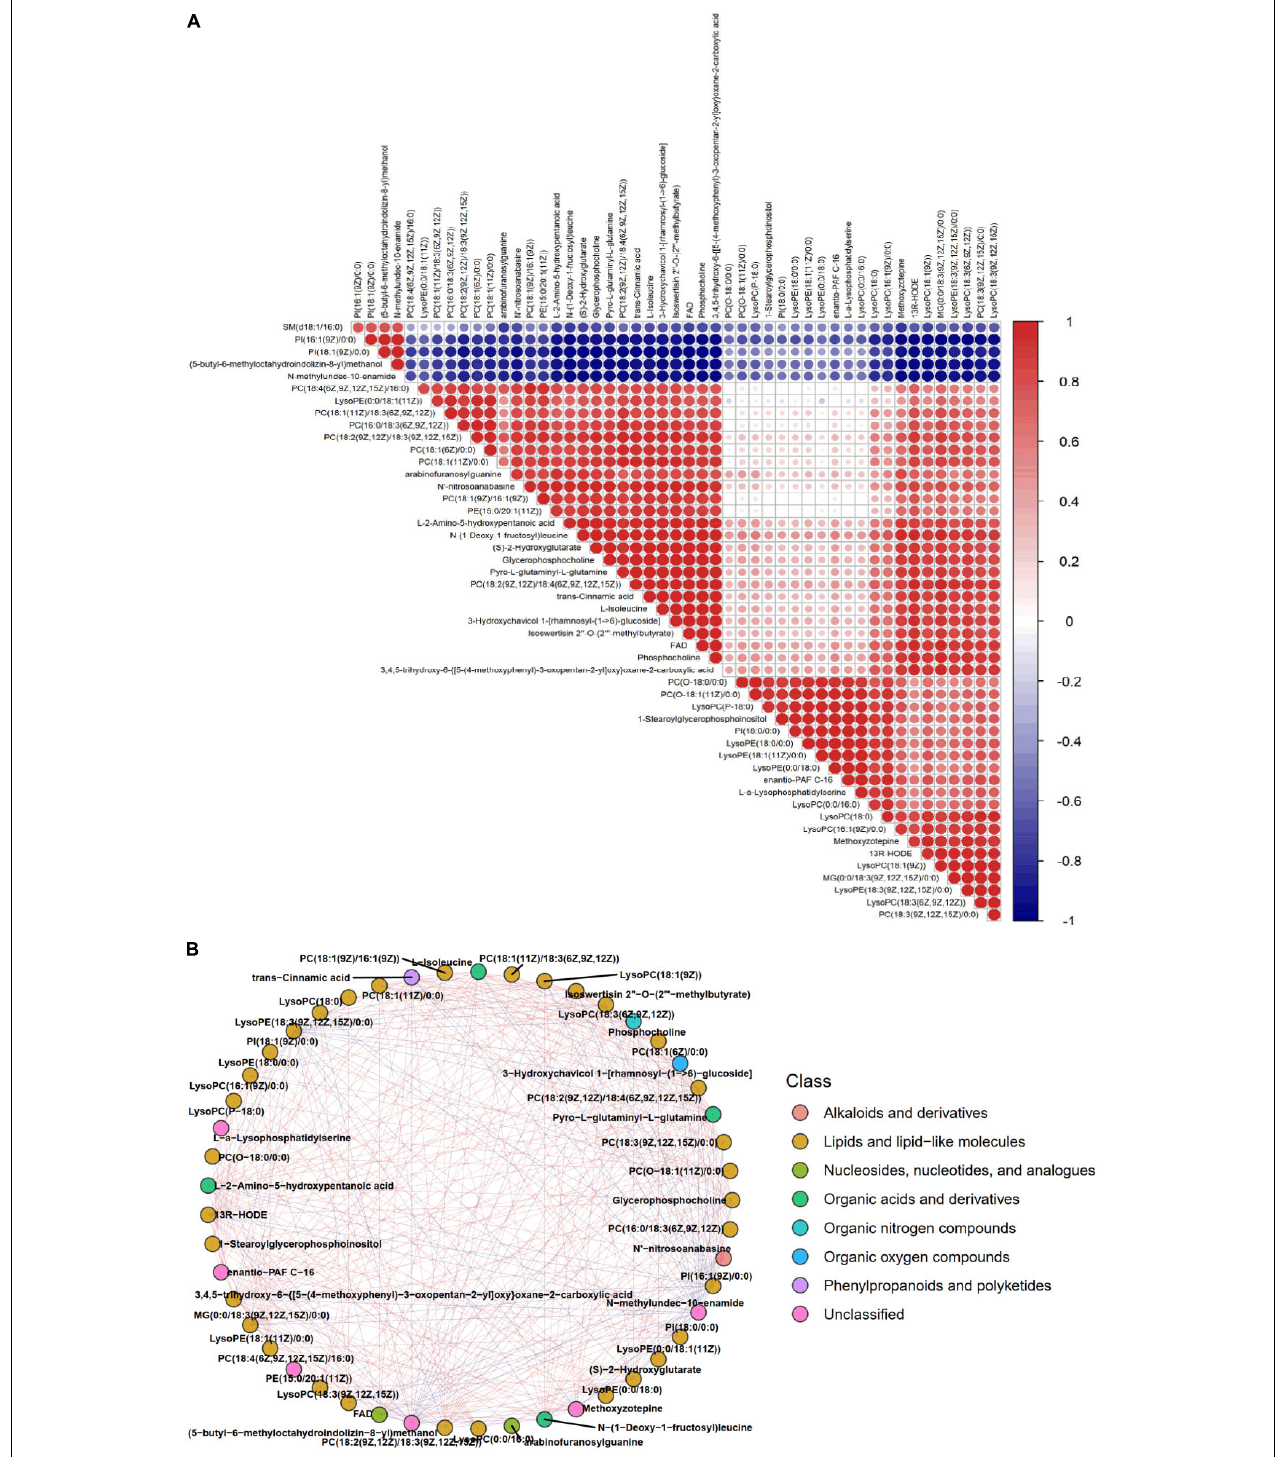
FIGURE 6 | Correlation analysis and network of differentially expressed metabolites in the comparison of NLQS with VQS in the honeybee Apis mellifera . (A) Pearson’s coefficients of correlation of variable importance in the projection values were used to analyze the correlations among metabolites between NLQS and VQS. Red, positive correlation; blue, negative correlation. Different sizes of circles indicated the correlation of Pearson’s coefficients. (B) Network of interactions among classes of differentially expressed metabolites. The Pearson correlation coefficient threshold was set to 0.9. Red lines represent positive correlations between substances, and blue lines represent negative correlations between